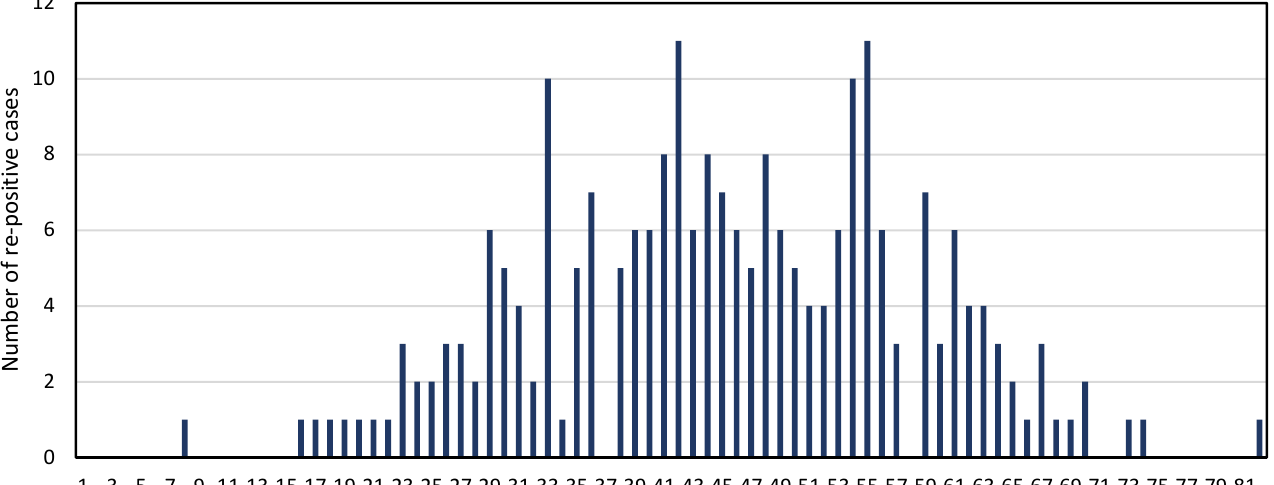
Figure 1. Time to confirmation of re-positive SARS-CoV-2 from initial symptom onset in Republic of Korea, 2020 ( n = 234).